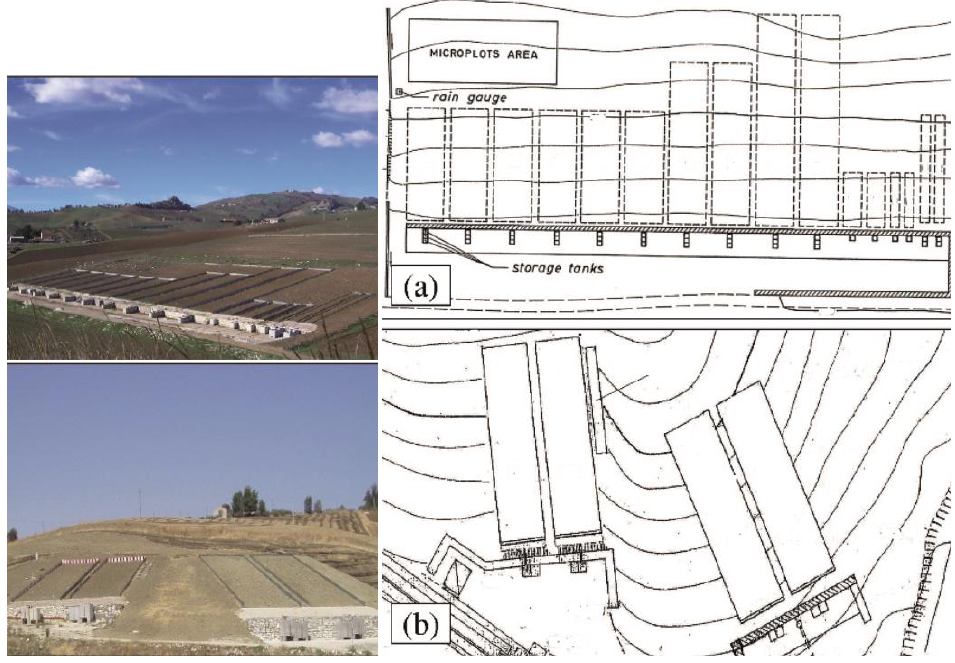
Figure 1. Plan and view of the experimental plots installed on the ( a ) 14.9% slope and ( b ) 22% and 26% slopes (modified from [1]).